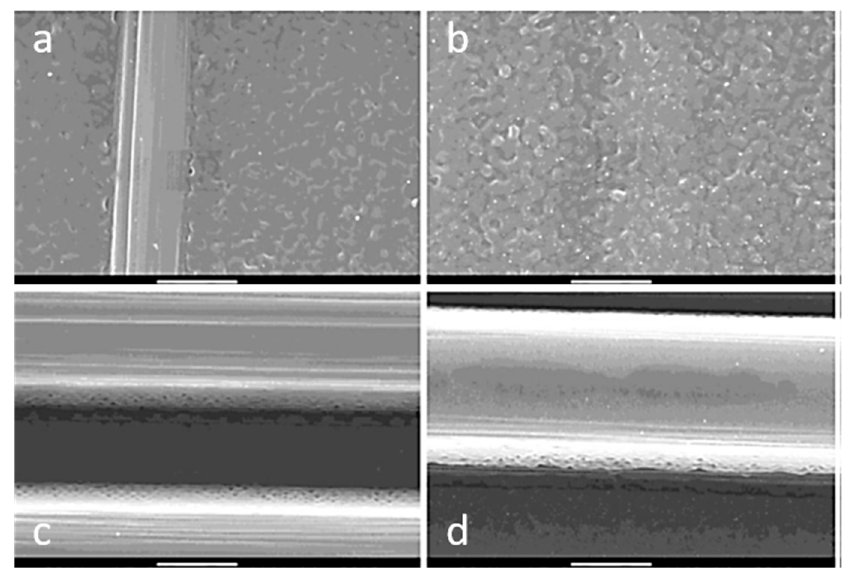
Figure 8. SEM pictures of laser-treated CFRP surfaces. ( a ): two pulses, 600 J / cm 3 ; ( b ): two pulses, 800 J / cm 3 ; ( c ): 16 pulses, 600 J / cm 3 ; ( d ): 16 pulses, 800 J / cm 3 . Scale bar = 5 µ m [157]. Reprinted from Phys. Procedia, Vol 41, Kreling et al. Analytical characterization of CFRP laser treated by excimer laser radiation, 282–290. Copyright (2013), with permission from Elsevier.